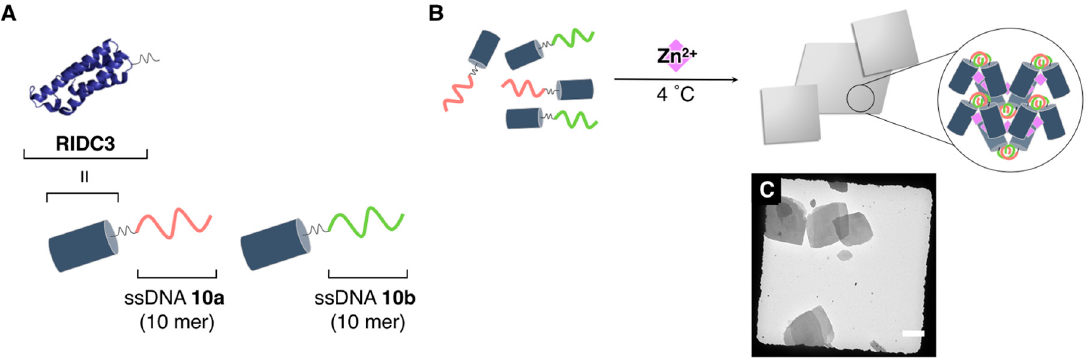
Figure 17. ( A ) Molecular design of the nucleoproteins ( RIDC3-10a and RIDC3-10b ). ( B ) Schematic representation and ( C ) a representative TEM image of the ordered crystalline architectures obtained through the complexation of RIDC3-10a / 10b with Zn 2+ under a small window of conditions. Scale bar: 5 μ m. Adapted from [119]. Copyright 2018 American Chemical Society.